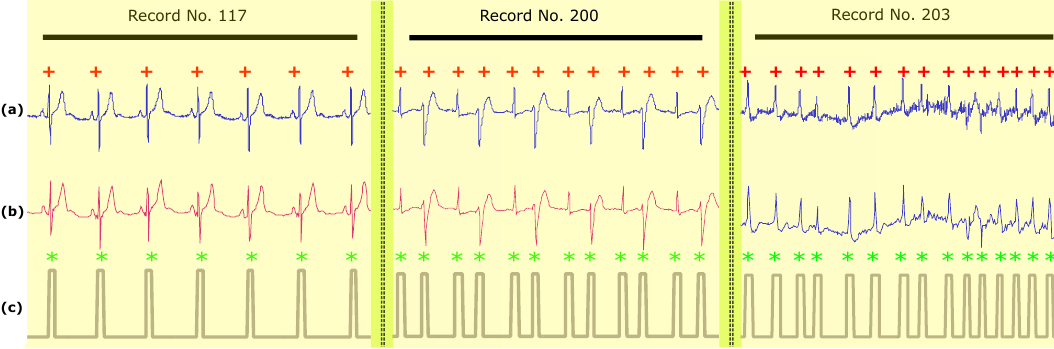
Figure 3. Heartbeat (QRS complex) detection over Records 117, 200, and 203 of the MIT-BIH Arrhythmia Database. ( a ) raw ECG signal ( b ) compressed ECG signal using Method III ( c ) compressed ECG signal using Method III. Record 117 contains regular beats with large T waves, Record 200 contains irregular beats (specifically premature ventricular contractions), and Record 203 contains severe baseline drift and noise. The y -axis represents manipulated signal amplitudes. Here, the red + represents the annotated R peak based on the MIT-BIH Arrhythmia Database while the green * represents the detected R peak using the two-event-related-moving-average(TERMA)-based QRS